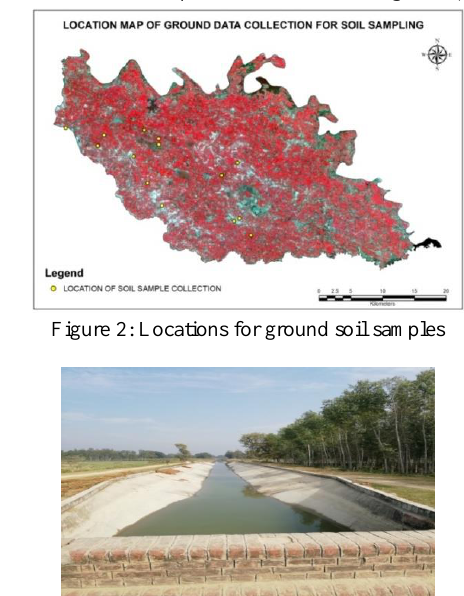
Figure 3: Restructured image of Haidergarh canal